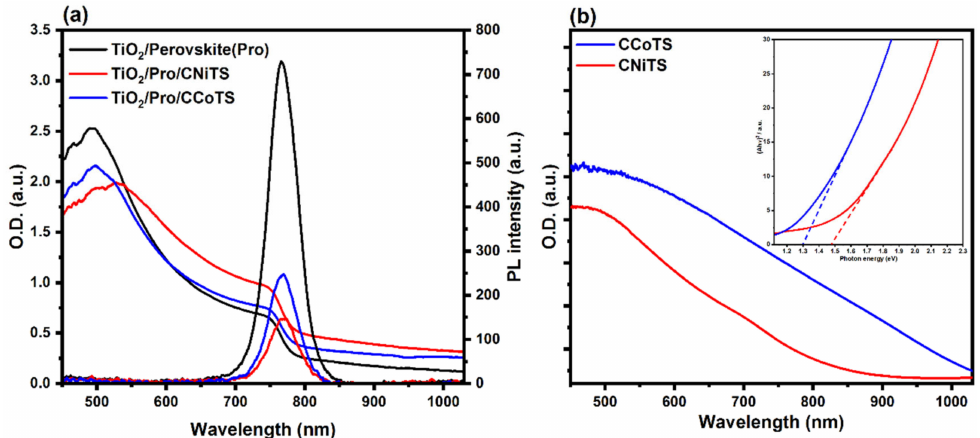
Figure 2. ( a ) UV-Vis absorption and steady photoluminescence (PL) spectra of the FTO / C-TiO 2 / M- TiO 2 / Perovskite / CMTS film stacks, and ( b ) UV-vis absorption spectra and the Tauc plot (inset) of CM(M = Ni, Co)TS films. Abbreviations: CMTS: Cu 2 M(M = Ni, Co)SnS 4 ; FTO: Fluorine-doped tin oxide.